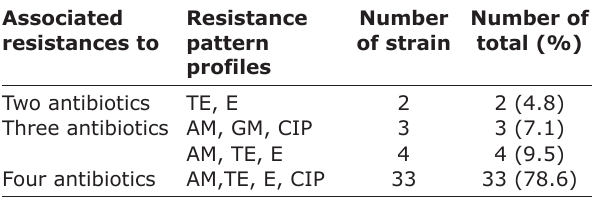
Table-2: Resistance pattern profiles of isolated Campylobacter coli strains. Associated resistances